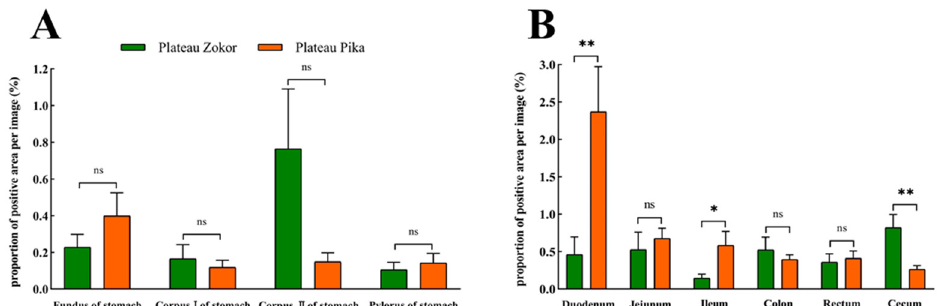
Figure 9. The difference in positive expression levels for Glu-immunoreactive cells in the gastroin- testinal organs of the plateau zokor and plateau pika. ( A ) In the stomach; ( B ) in the intestinal tract. * and ** indicate significant interspecific difference ( p < 0.05, p < 0.01); ns indicates an insignificant interspecific difference.